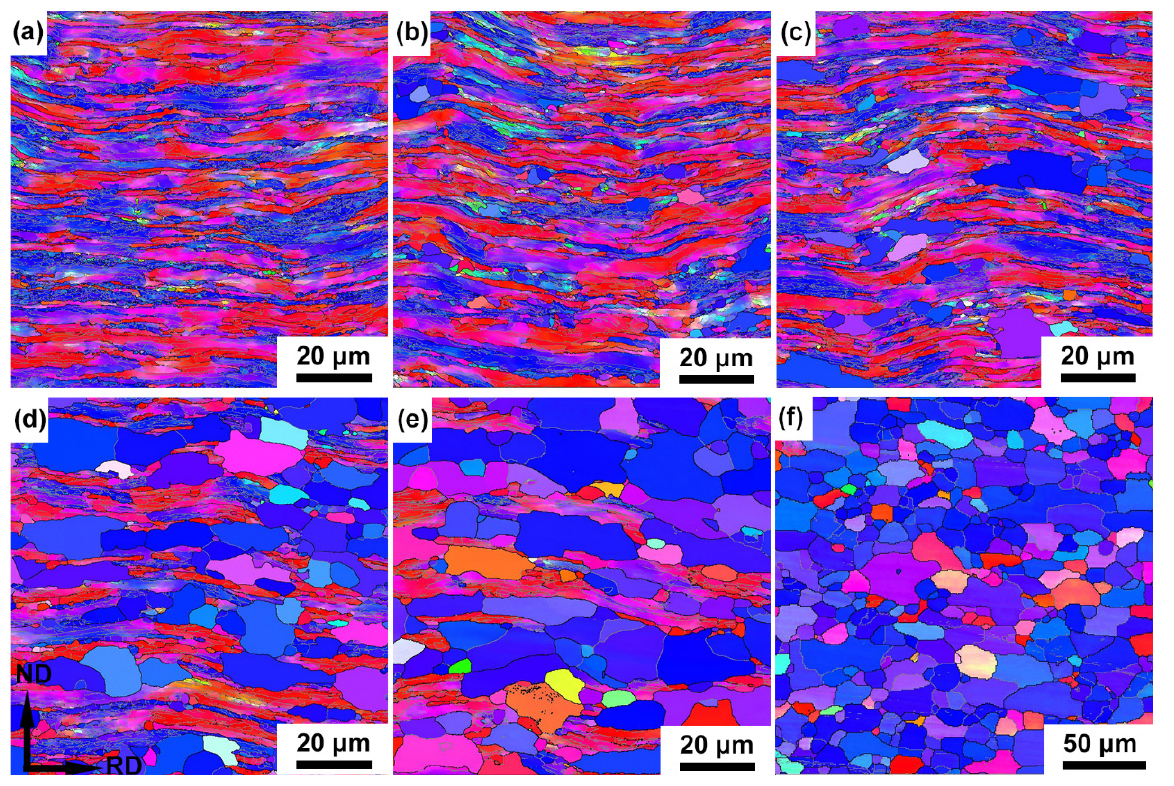
Figure 2. Orientation maps of partially recrystallized microstructures of the cold-rolled IF steel annealed at 600 ° C for ( a ) 2 h, ( b ) 4 h, ( c ) 8 h, ( d ) 16 h, ( e ) 32 h and ( f ) 64 h.